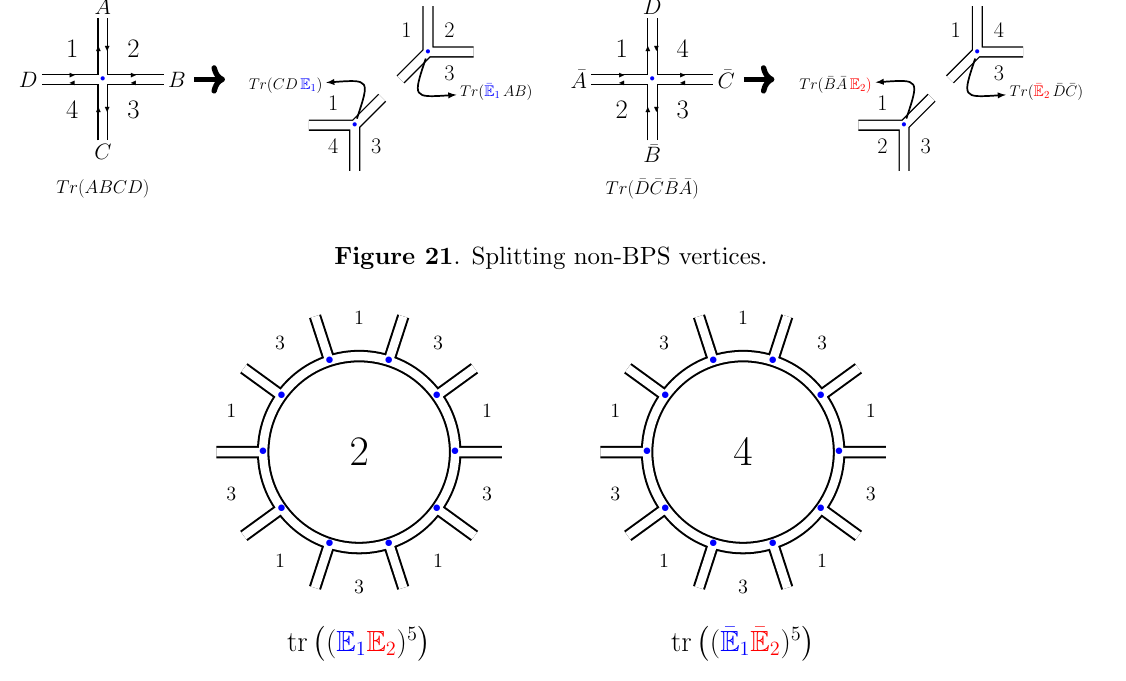
Figure 22 . Genus four non-BPS example: Integrating out faces 2 and 4 gives a single two-point function of traces with two complex